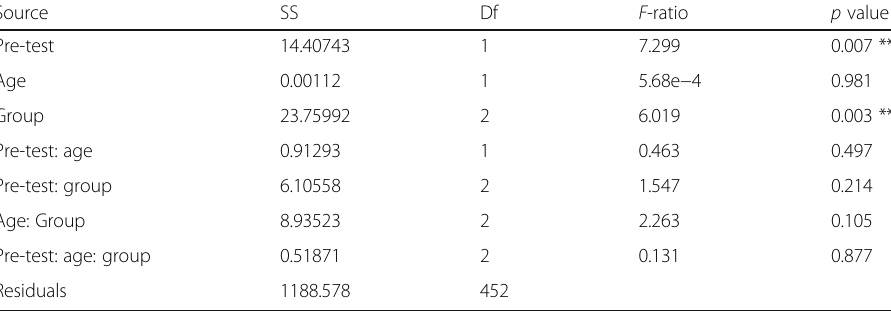
Table 11 Analysis of covariance (ANCOVA) type II SS results for Material 2 Source SS Df F -ratio p value Pre-test